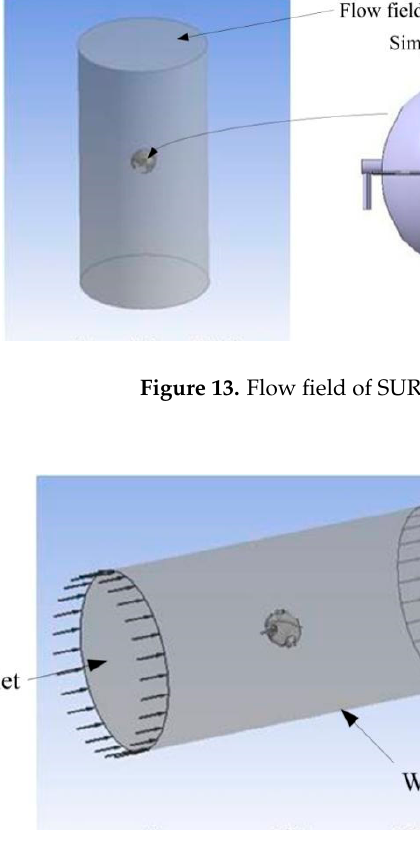
Figure 14. Fluid boundary setting.